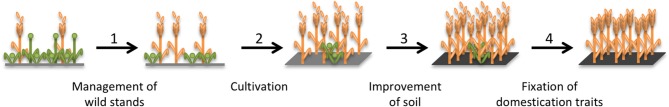
Schematic of a protracted model for the transition from gathering of a wild grass to cultivation of a domesticated cereal crop. The key steps are: (1) management of wild stands by removal of competing plants in order to increase the proliferation of the food sources; (2) initial cultivation of wild plants in artificial stands; (3) improvement of the soil; (4) fixation of domestication traits.